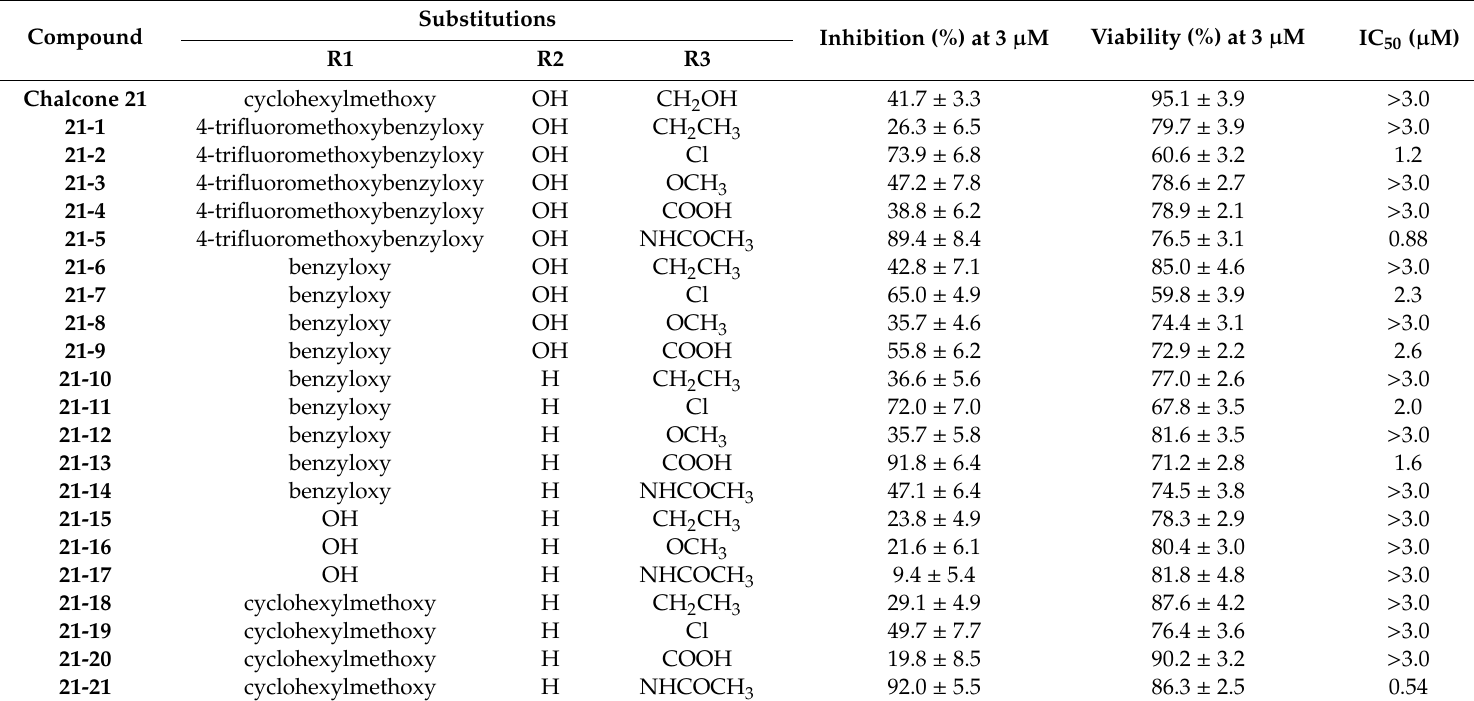
Table 1. Inhibitory e ff ect of the derivatives of chalcone 21 on melanin production in α -MSH-stimulated B16F10 cells. B16F10 cells were incubated for 3 days with each compound in the presence of α -MSH (10 nM) and data are expressed as mean ± SD based on three independent experiments ( n =